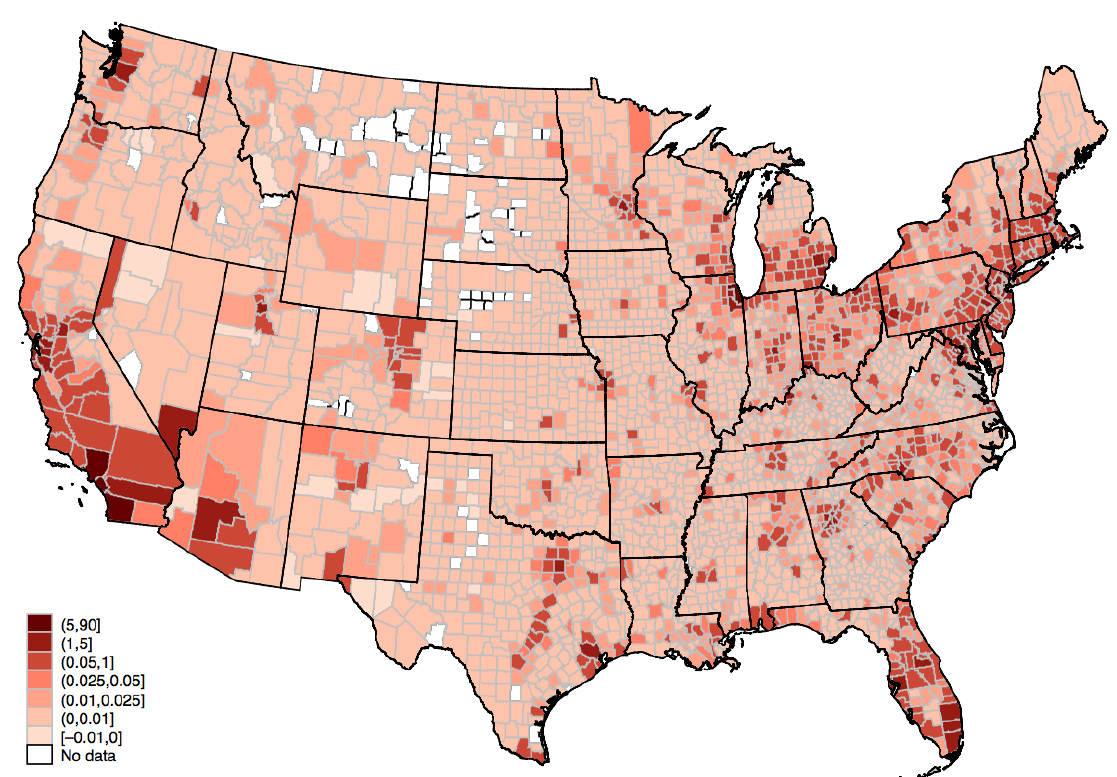
Figure A4. Reduction in deaths: travel. Notes: Figure shows monthly reduction in expected deaths from reduced travel in each county.